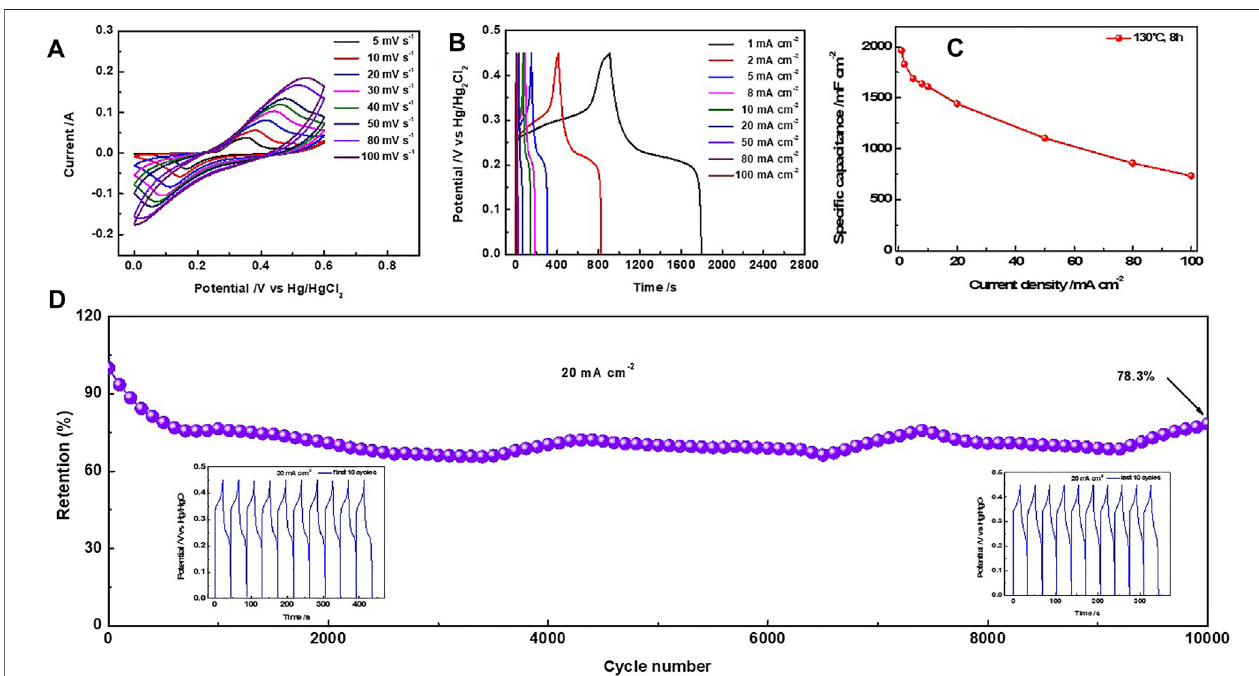
FIGURE3|(A) CVcurvesoftheNi@SnS 2 nanosheetarraysatdifferentscanrates; (B) GCDcurves; (C) Rateperformance; (D) Cyclestabilityat20 mA cm − 2 (inset: the lower left corner shows the GCD curves of the fi rst 10 cycles, and the lower right corner shows the GCD curves of the last 10